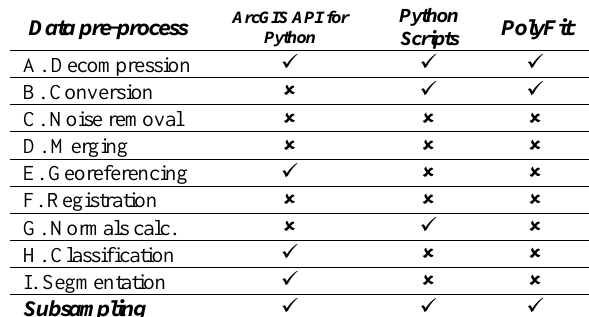
Table 7. Pre-processing steps applied to the data so that is ready for the reconstruction test ( ✓ : Applied /  : Not